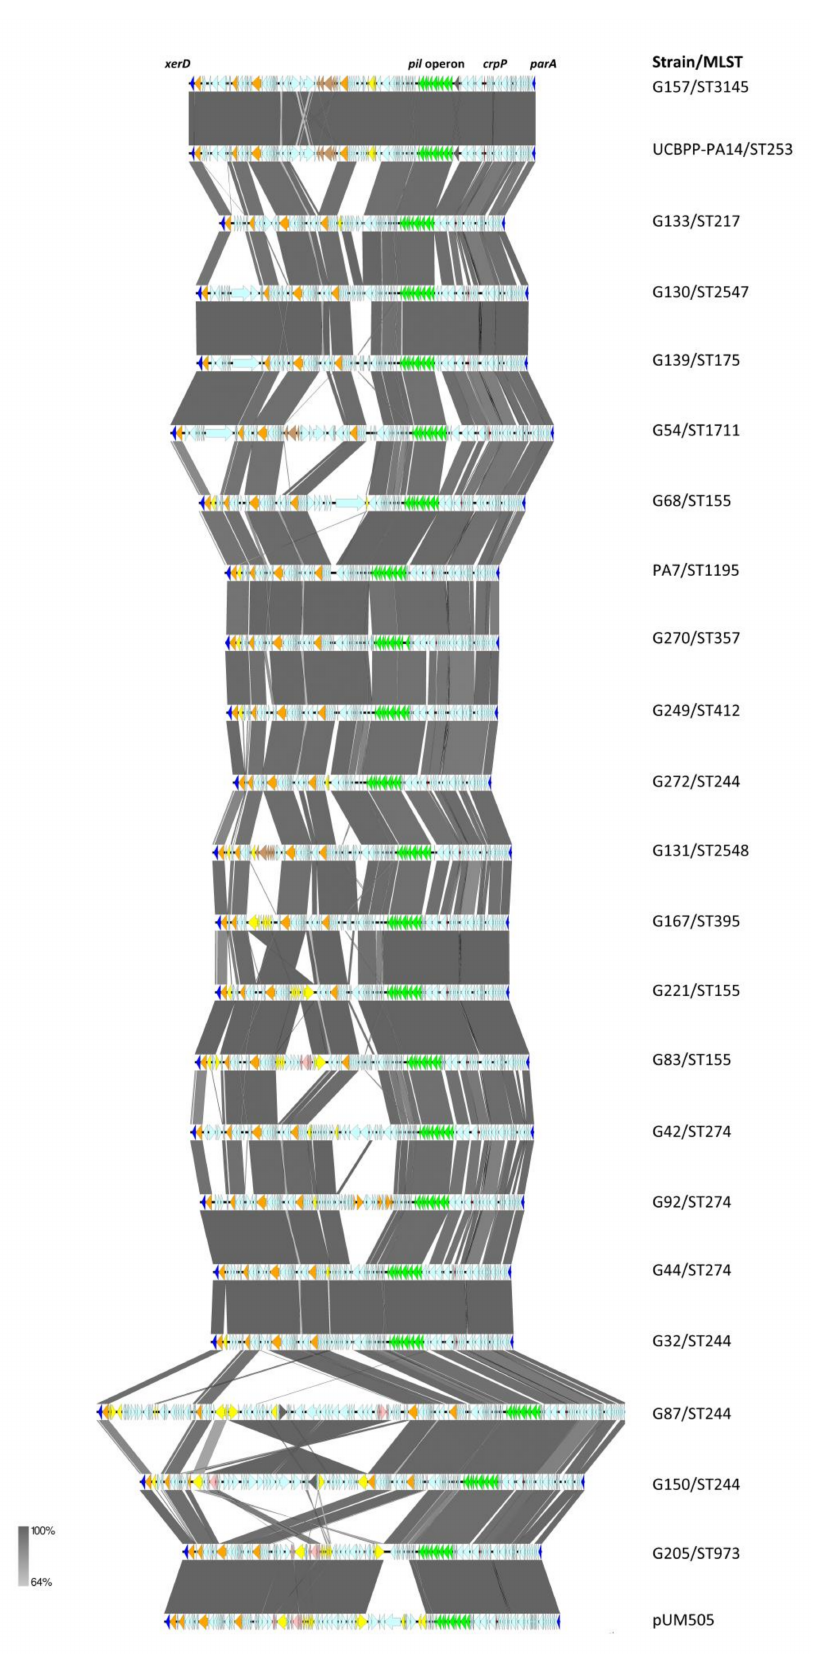
Figure 4. Comparison of different genetic environments of crpP -harbouring P. aeruginosa . Arrows represent genes and indicate the orientation. Relevant genes are indicated by colored arrows as